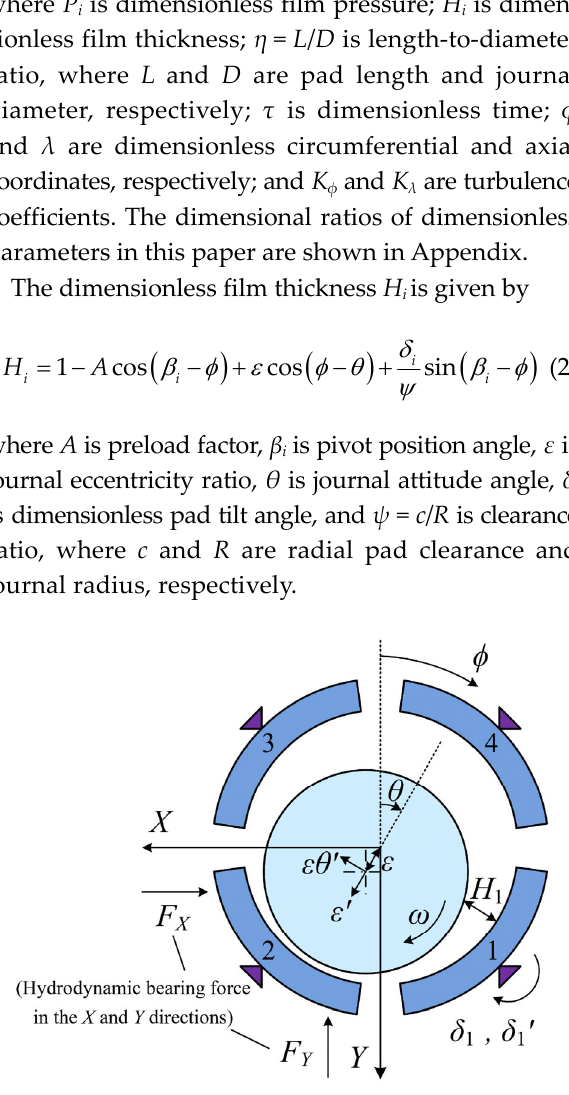
Fig. 1 Geometry and coordinate of a four-pad